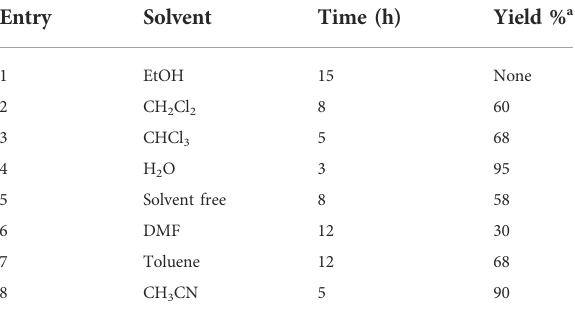
TABLE 2 Determining the best solvent for the generation of